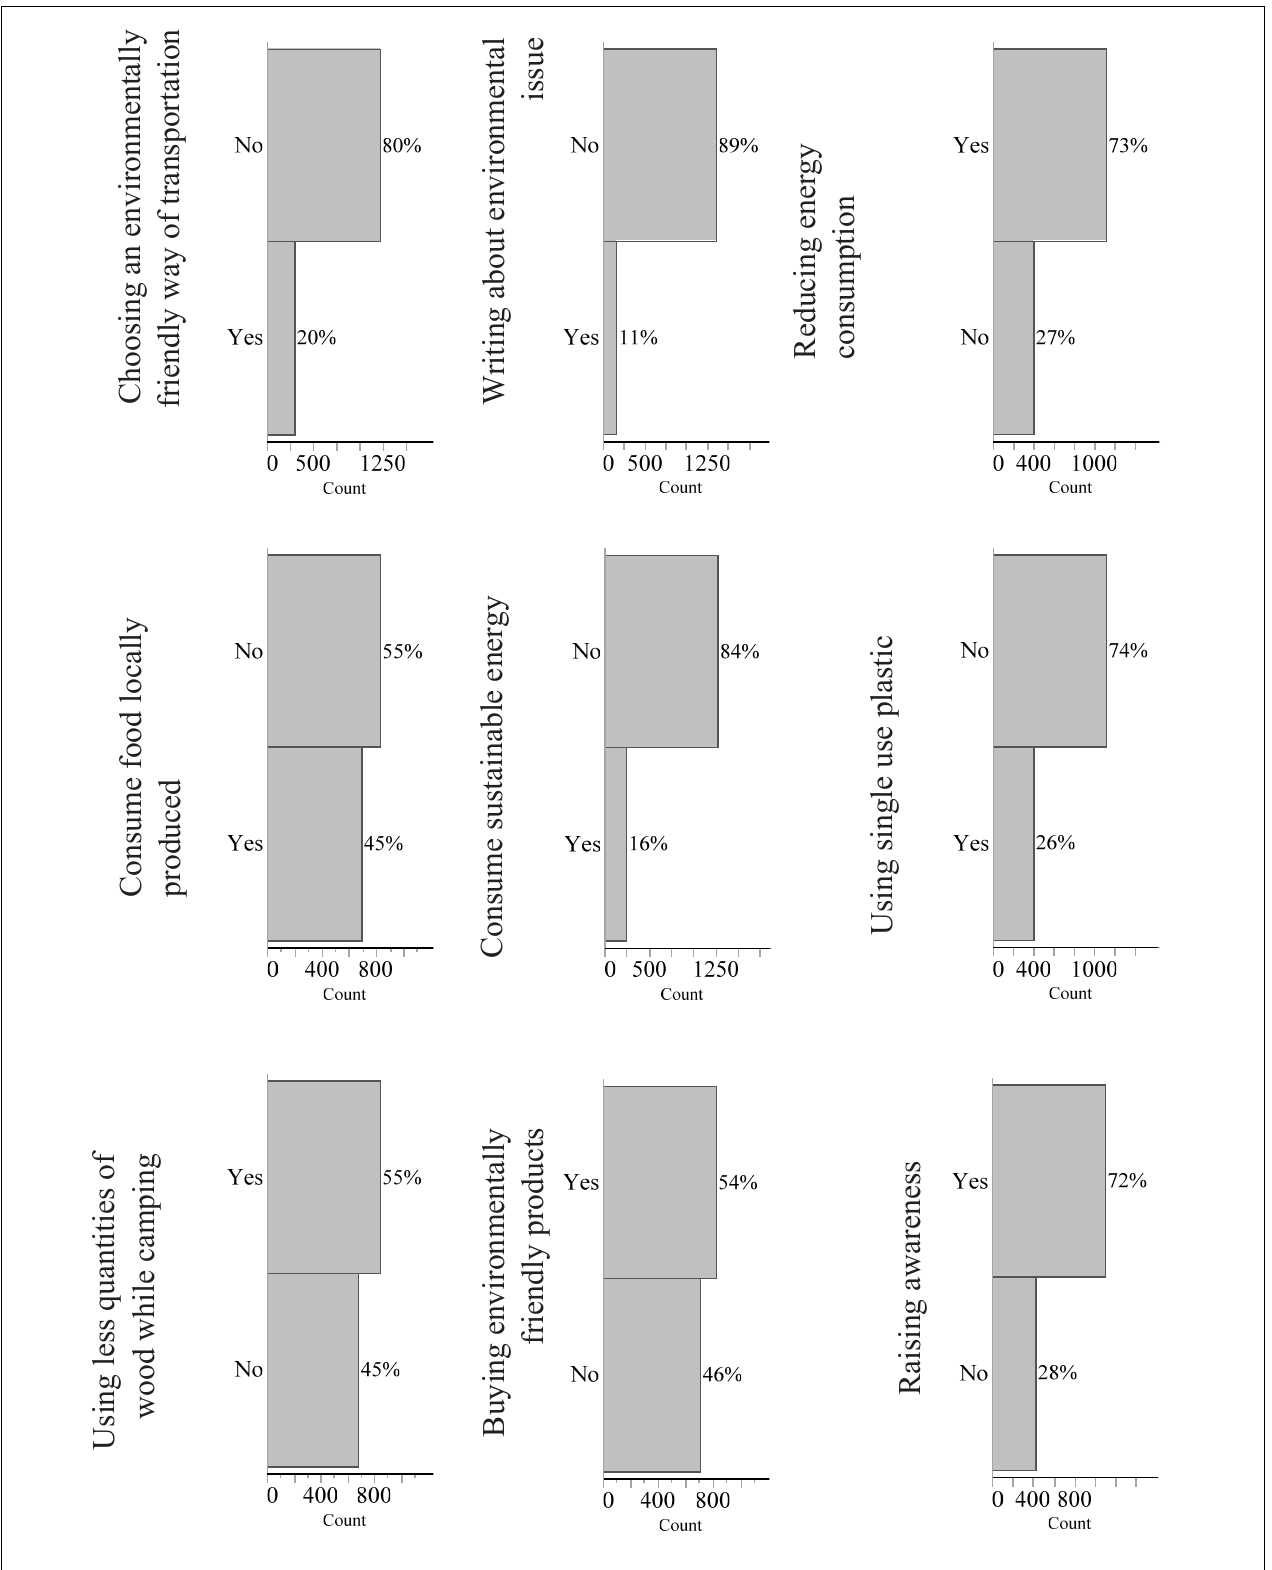
FIGURE 7 | Responses to the question: Please indicate whether you have taken any of the following actions to reduce and cope with the impacts of marine environmental issues.